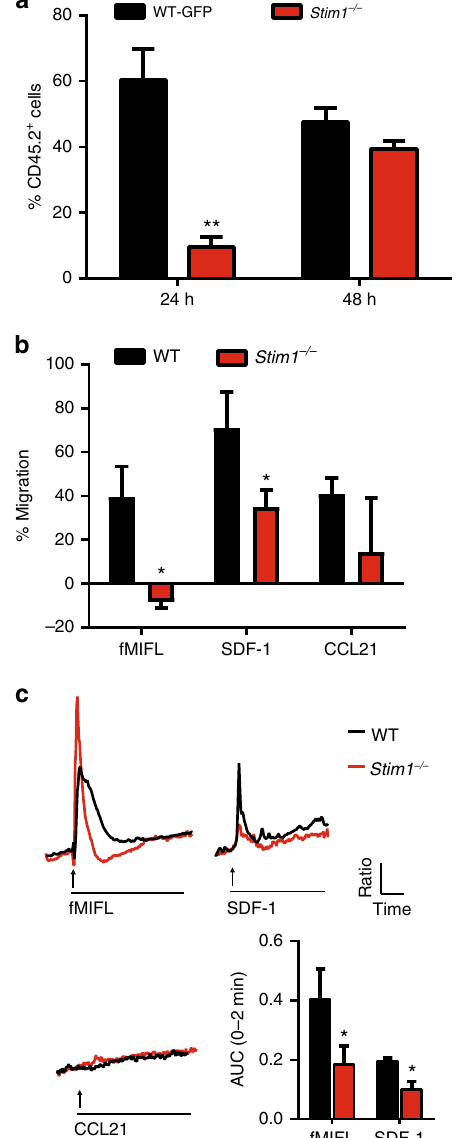
Fig. 2 STIM1 promotes Ca 2+ -dependent migration in vivo and in vitro. a CD45.1 congenic wild-type hosts were injected with a mixture of 1 × 10 6 wild-type GFP+ (WT-GFP), 1 × 10 6 Stim1 − / − BMDCs and 0.5% OVAb. DL were isolated and the relative percentage of WT: Stim1 − / − (CD11c + , CD45.2 + ) cells analysed by fl ow cytometry. Full gating strategy is shown in Supplementary Fig. 2a. The proportion of Stim1 − / − cells was signi fi cantly reduced 24 h but not 48 h after injection. N = 4 pairs of mice. b A 24 h transwell migration assay revealed 40 – 65% increases in migration towards fMIFL, SDF-1 and CCL21 chemoattractants in WT cells. Stim1 − / − BMDC showed reduced migration towards fMIFL and SDF-1 but not CCL21 (all applied at 10 − 6 M) as compared to WT. Full gating strategy is shown in Supplementary Fig. 2b. N = 3 in triplicate wells. c Ca 2+ transients induced by acute exposure (arrows) of chemoattractants, as measured using Fura-2 (traces representative average of 14 – 22 cells). Quanti fi cation of the area under the curve (AUC) of the fi rst 2 min after chemoattractant addition (right bottom panel) revealed signi fi cantly lower Ca 2+ entry in Stim1 − / − BMDCs in response to fMIFL and SDF-1, while no Ca 2+ entry in response to CCL21 was detected for either genotype. N = 4 (coverslips each) containing: 68/66/72 (WT) or 47/56/52 ( Stim1 − / − ) cells for fMIFL/SDF- 1/CCL21. Error bars are means + SEM, * p < 0.5, ** p < 0.1 using a two-way ANOVA and Sidak ’ s post test for a and a Student ’ s t -test for b and